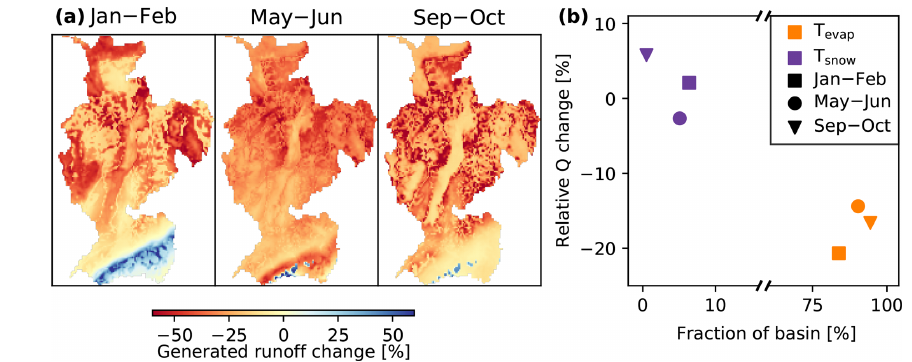
Figure 6. Spatial differences in the Rhine Basin under the + 2 . 5 ◦ C scenario. Panel (a) shows the differences in generated runoff for the three periods highlighted in Fig. 5a. Panel (b) shows the fraction of the basin where 80% of the changes could be explained by either evaporation or snowmelt and the average discharge change corresponding to each